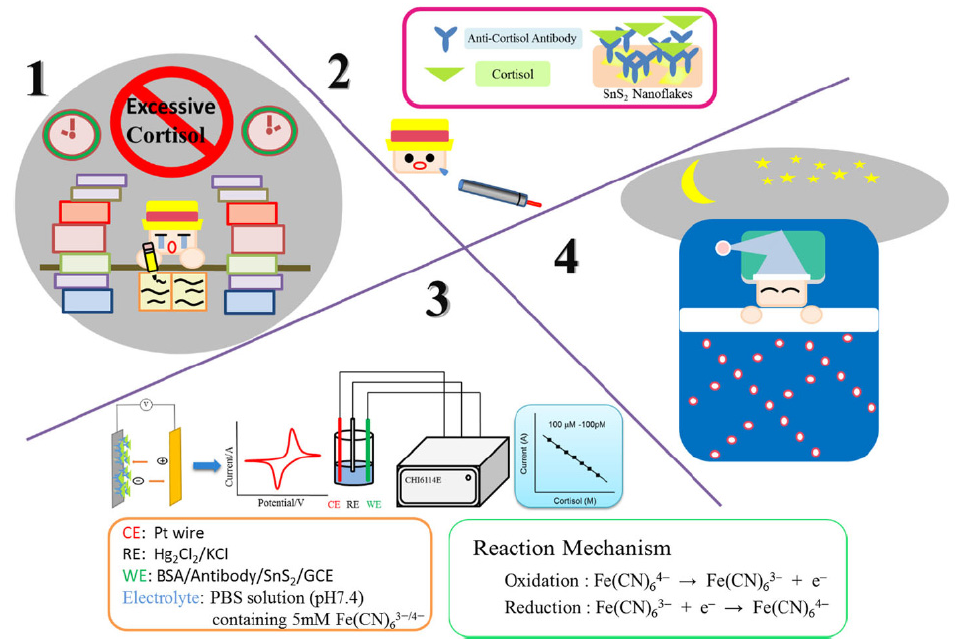
Figure 11. The schematization of the new type of rapid point-of-care test for the detection of salivary cortisol (reproduced with permission from [68]. Copyright 2019 Springer).